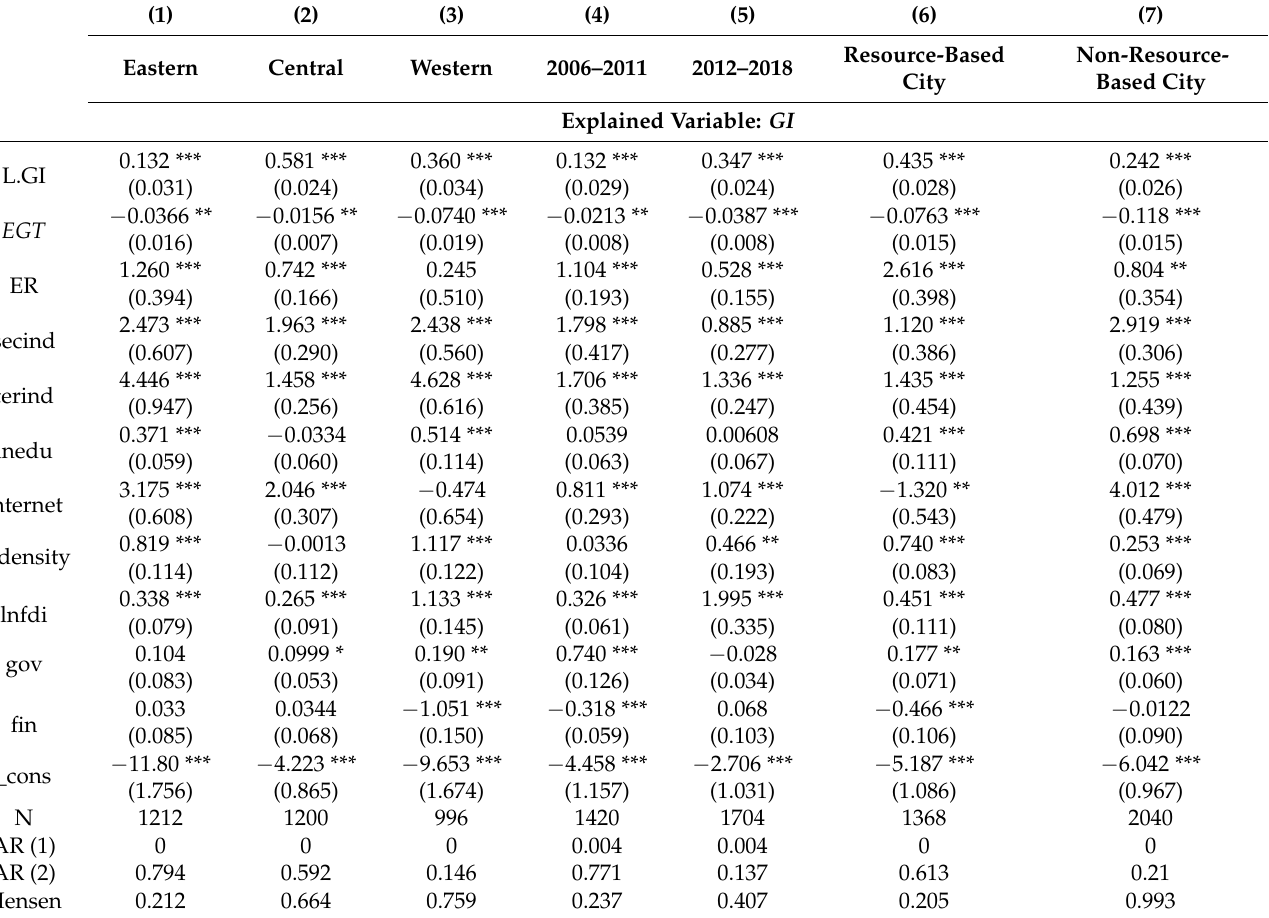
Table 5. Results of heterogeneity